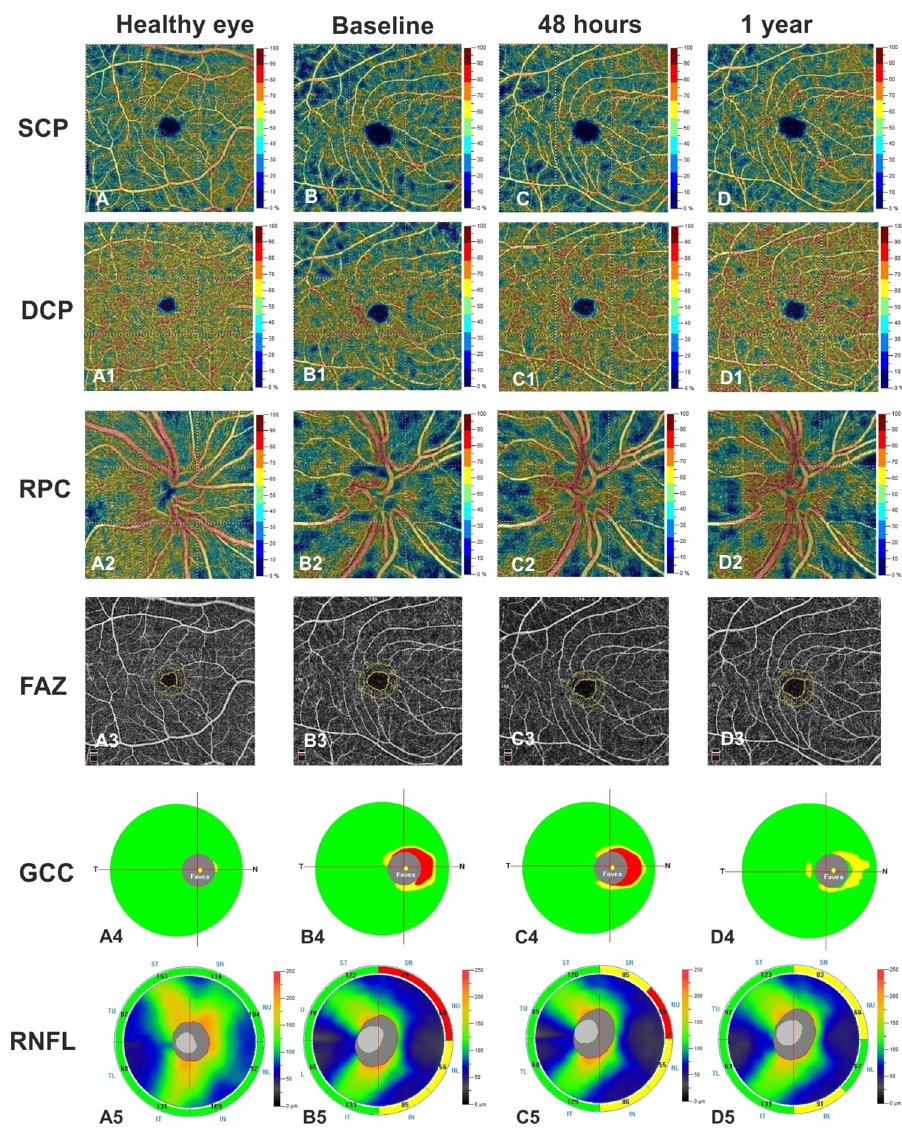
Fig 2. Right eye of a healthy subject (48 years-old man) shows normal vessel density of the superficial capillary plexus (SCP) (A), deep capillary plexus (DCP) (A1), radial peripapillary capillary (RPC) plexus (A2), and foveal avascular zone (FAZ) area (A3) at Optical Coherence Tomography Angiography (OCTA). Right eye of a patient (51 years-old man) with pituitary adenoma before surgery reveals a reduction of vessel density in SCP (B), DCP (B1), RPC (B2) and an increase of FAZ area (B3) compared to healthy subject. At 48 hours after endoscopic endonasal surgery, a slight increase was found in vessel density of the SCP (C), DCP (C1), while a significant increase was shown in vessel density of the RCP (C2) compared to baseline. At 1 year of follow up a significant improvement of vessel density in macular and papillary regions was found compared to other time points (D-D2). FAZ area did not change over time (B3, C3, D3). Structural Spectral Domain OCT (SD-OCT) reveals normal thickness of the Ganglion Cell Complex (GCC) (A4) and Retinal Nerve Fiber Layer (RNFL) (A5) in right eye of the healthy control. The patient shows a focal reduction in GCC and RNFL (B4, B5) at baseline, a slight decrease in GCC (C4) and an absence of changes in RNFL (C5) at 48 hours after surgery. At 1 year of follow up a significant improvement was found in both SD-OCT parameters (D4, D5).